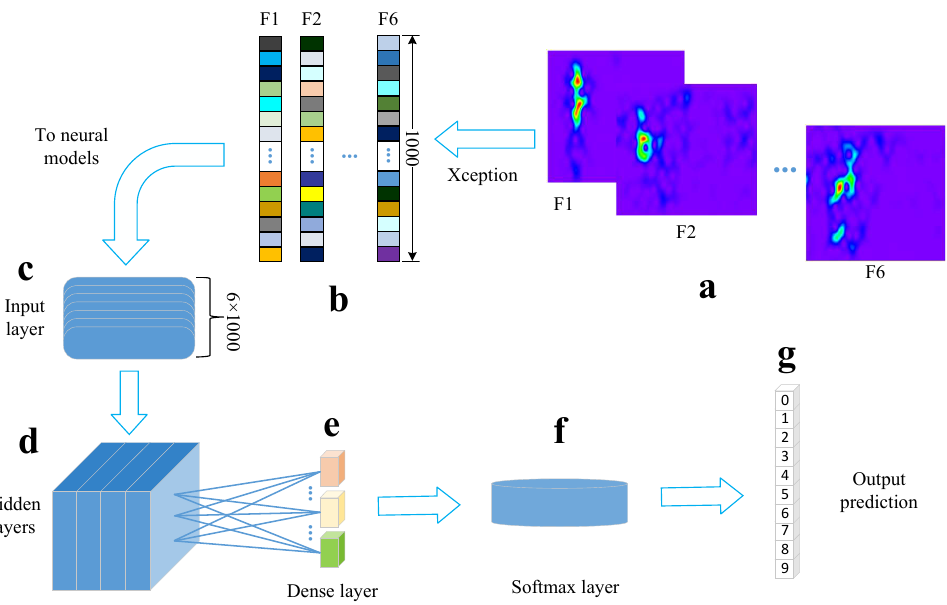
Figure 6. Decoding processes. ( a ) Spectrogram images. ( b ) Feature set extracted by Xception. ( c ) Input layer of neural networks. ( d ) Hidden layers of neural networks. ( e ) Fully connected dense layer. ( f ) Softmax layer as the output layer. ( g ) The predicted labels we obtain from the